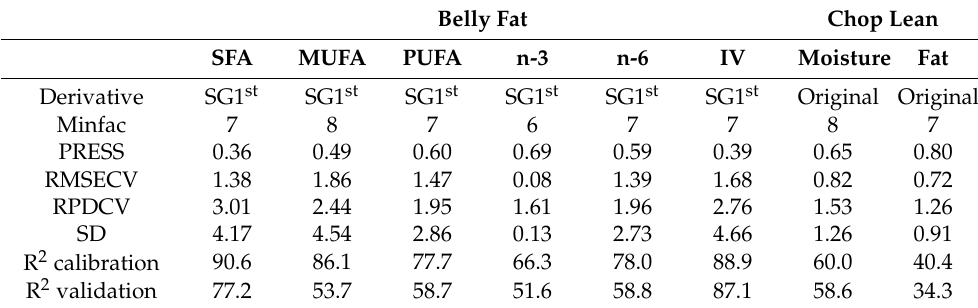
Table 1. Prediction parameters (Tellspec NIR on the pork belly primal fat samples and the loin chop lean samples) for fat compositional measures in belly fat and fat and moisture content in chop. Belly